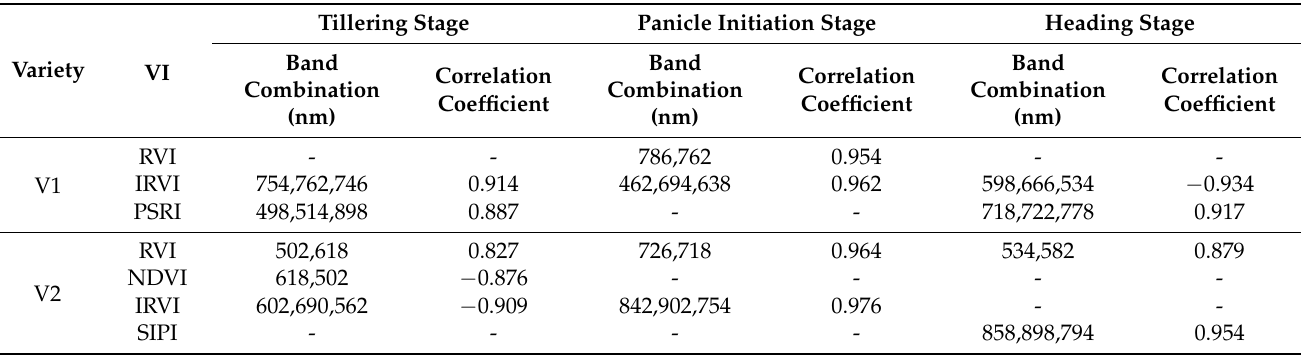
Table 5. Relationships between plant nitrogen accumulation (PNA) and optimal spectral indices for different rice varieties ( n = 15).